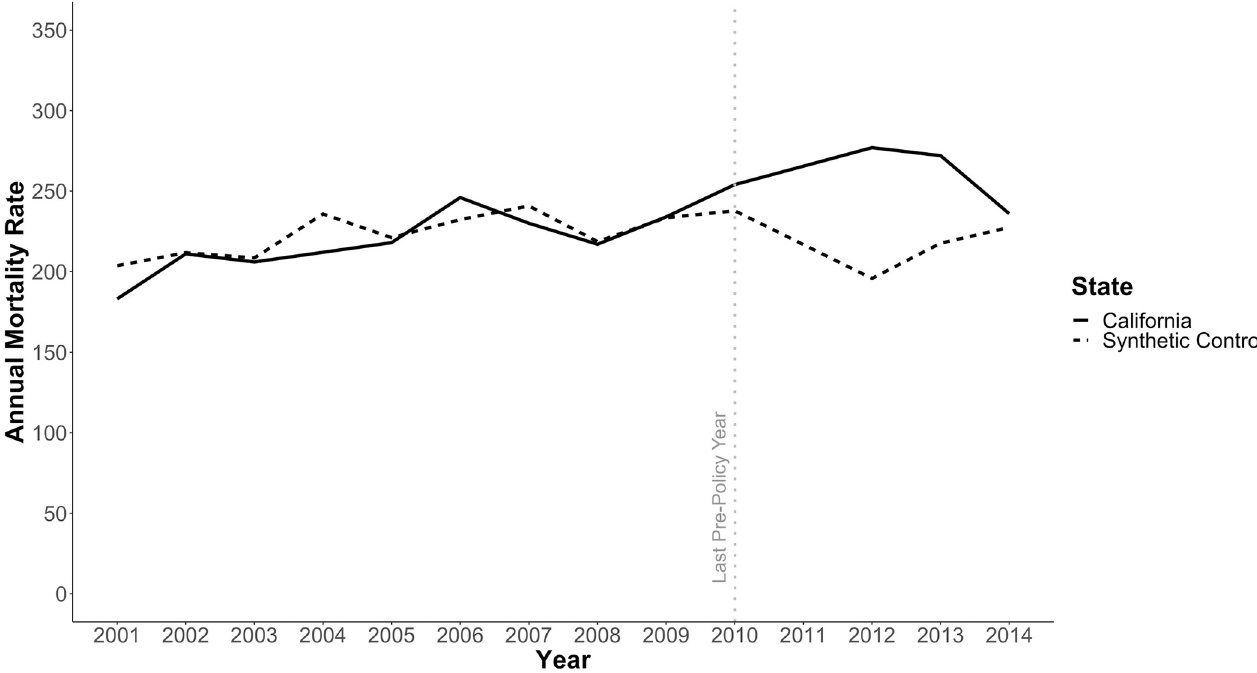
Fig 1. Annual prisoner mortality rate for California and synthetic control, 2001–2014.